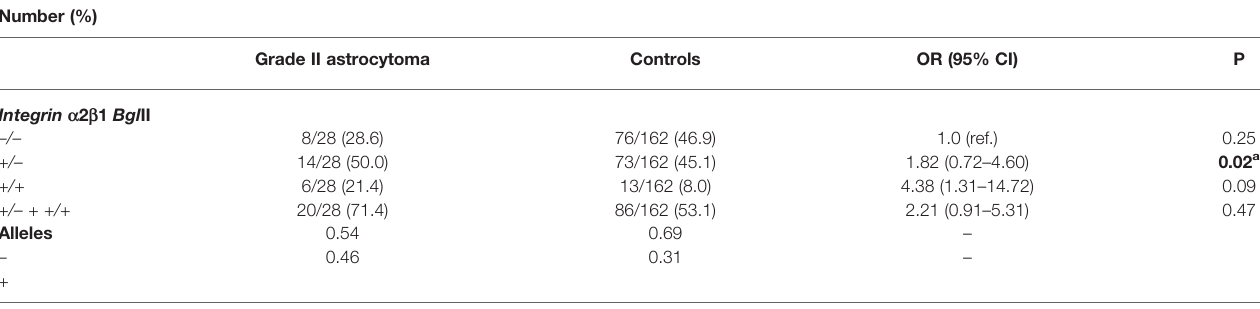
TABLE 2 | Distribution of allele and genotype frequencies of polymorphisms and statistical data obtained from the analysis of integrin a 2 BglII polymorphisms in the astrocytoma grade II and control. Number (%)